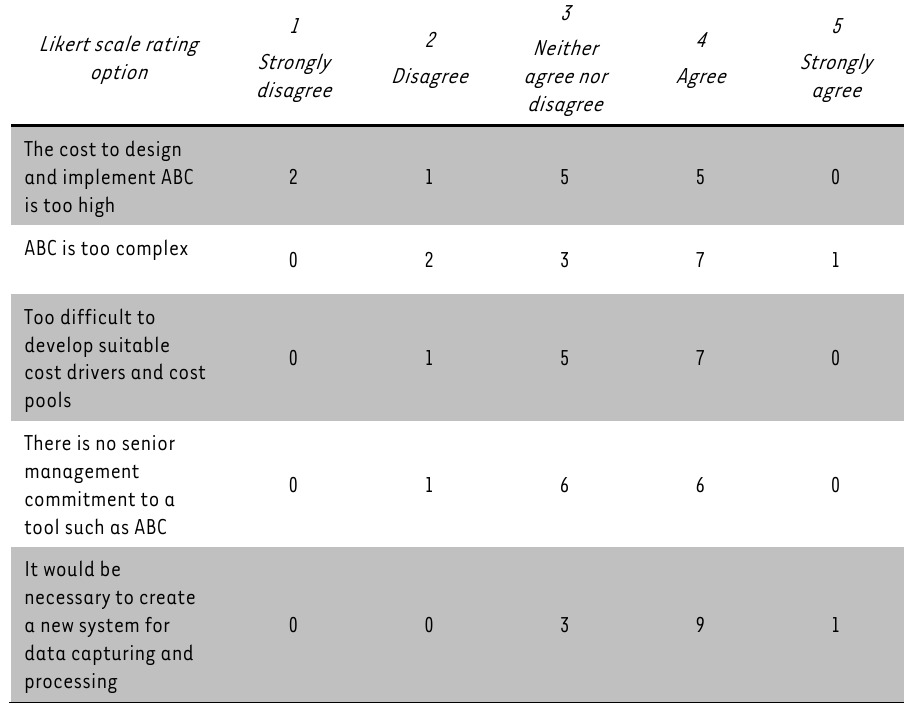
TABLE 1: Reasons not to adopt ABC Likert scale